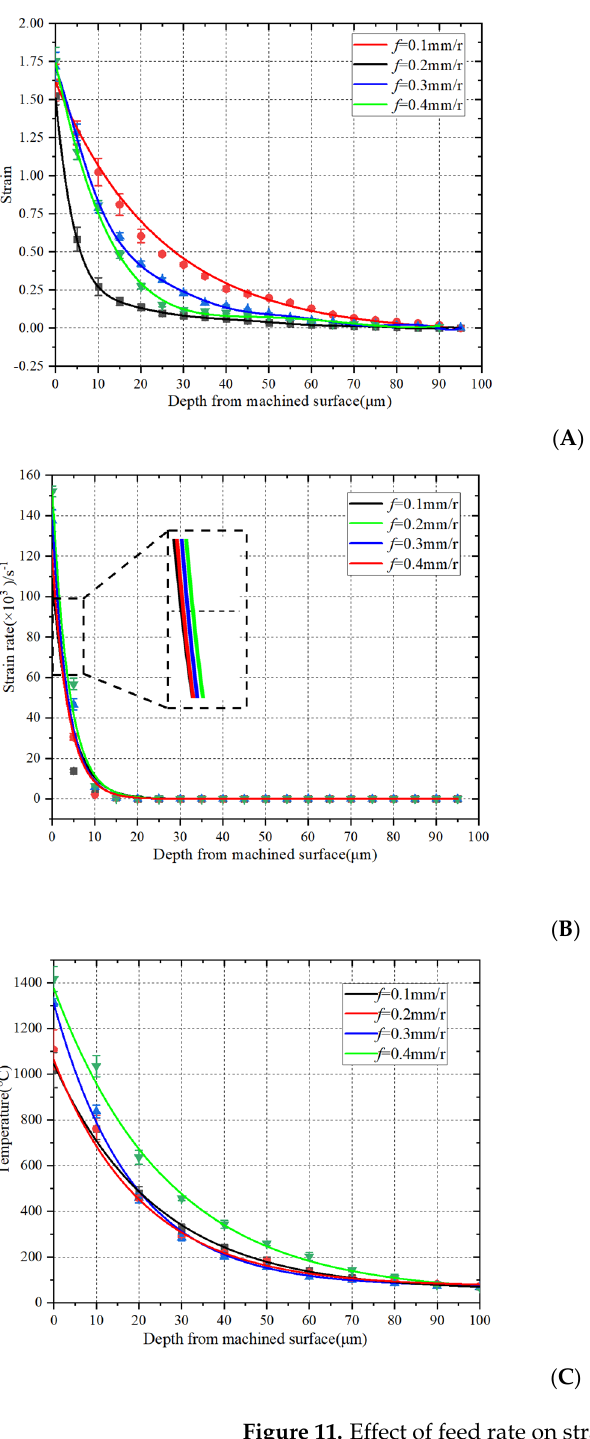
Figure 11. Effect of feed rate on strain, strain rate and temperature of machined surface. ( A ) Effect of feed rate on strain of machined surface. ( B ) Effect of feed rate on strain rate of machined surface. ( C ) Effect of feed rate on temperature of machined surface.